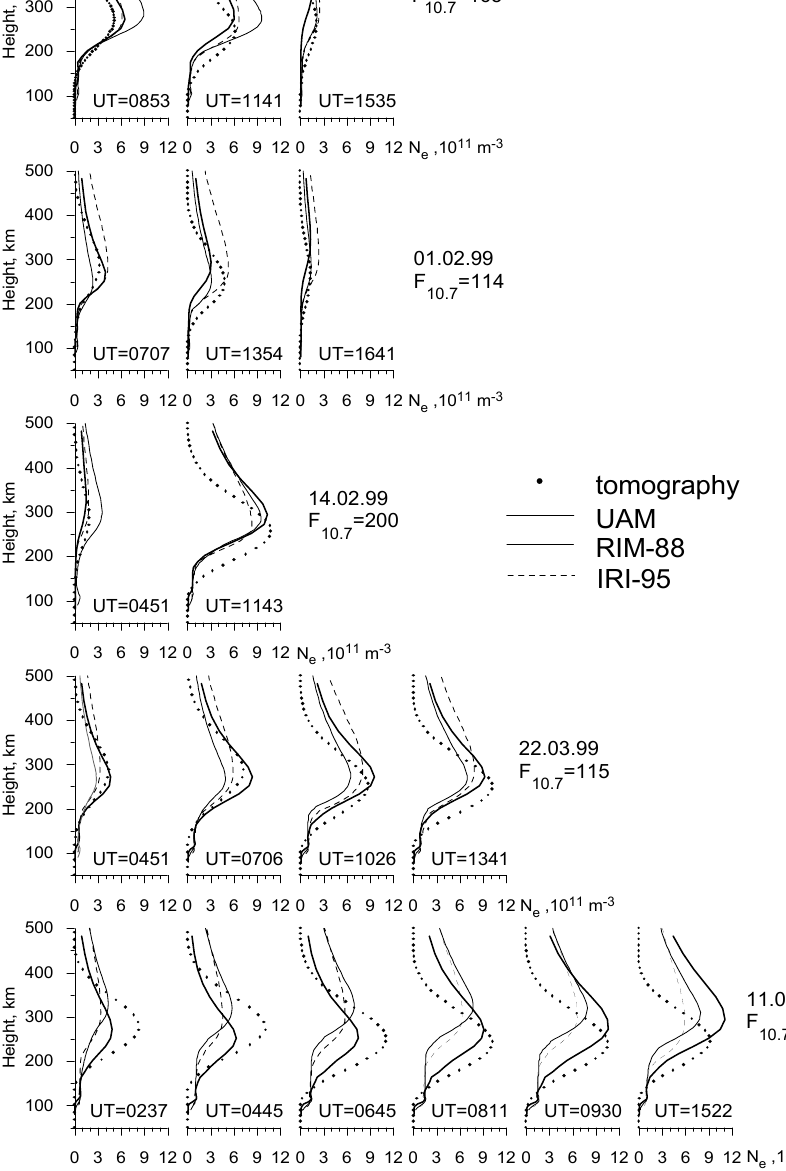
Fig. 9. Height profiles of the electron density N e ( × 10 11 m − 3 ) extracted from the reconstructed and simulated data in the centre of the examined region ( ϕ = 67 ◦ N) in the daytime sector of the selected